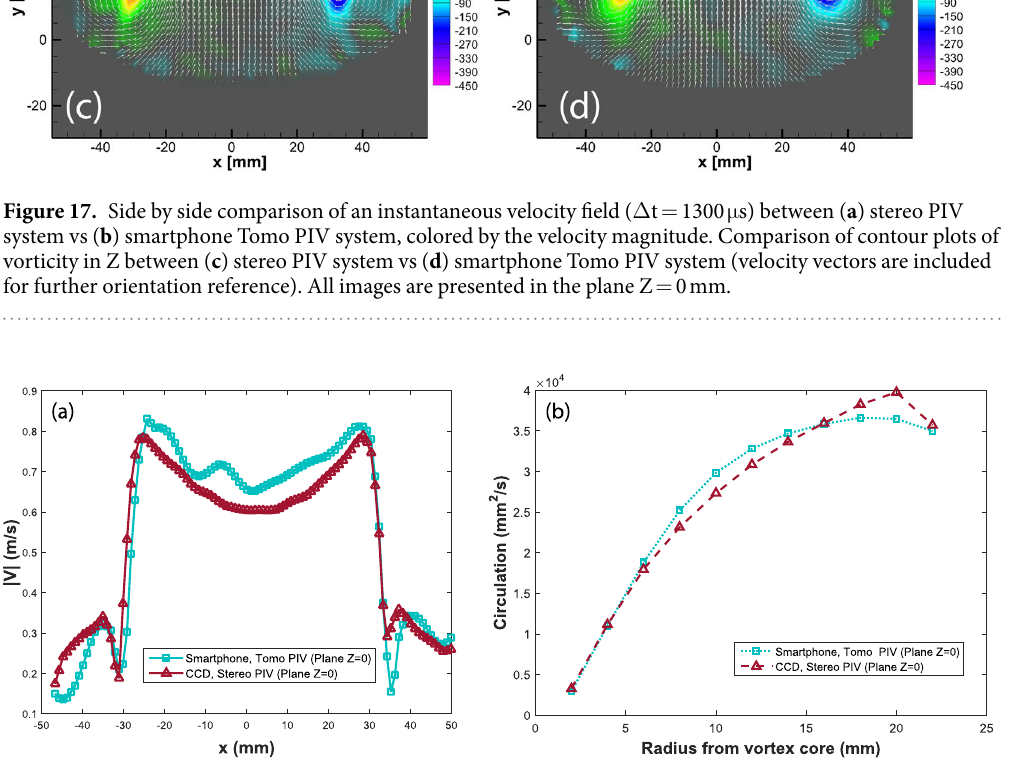
Figure 18. ( a ) Comparison of the velocity magnitude along a cut through the vortex cores in the plane Z = 0 mm for our Tomo-PIV system (cyan) vs 2-camera stereoscopic PIV system (red). ( b ) Comparison of the circulation Γ as a function of the radial distance from the center of the vortex